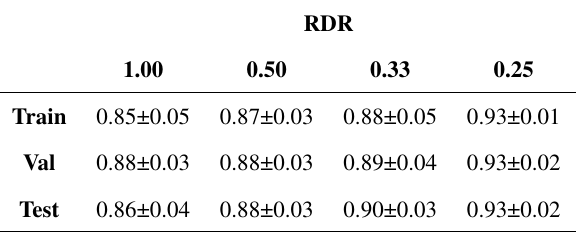
Table 2. DSC of the modified U-net with different RDR values